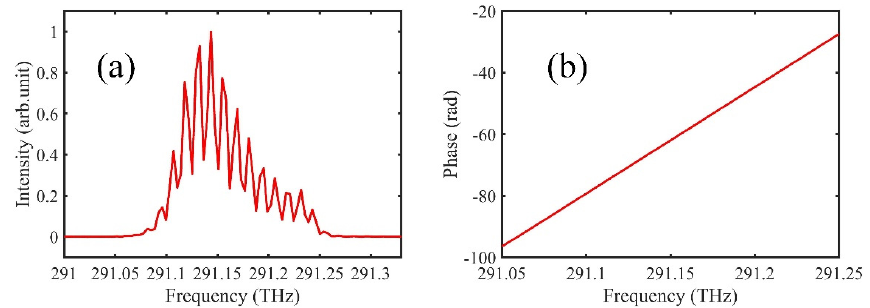
Figure 3. ( a ) Measured spectral interferogram. The x-axis is optical frequency; ( b ) Unwrapped phase obtained by fast Fourier transform. The slope of the unwrapped phase can be easily measured.